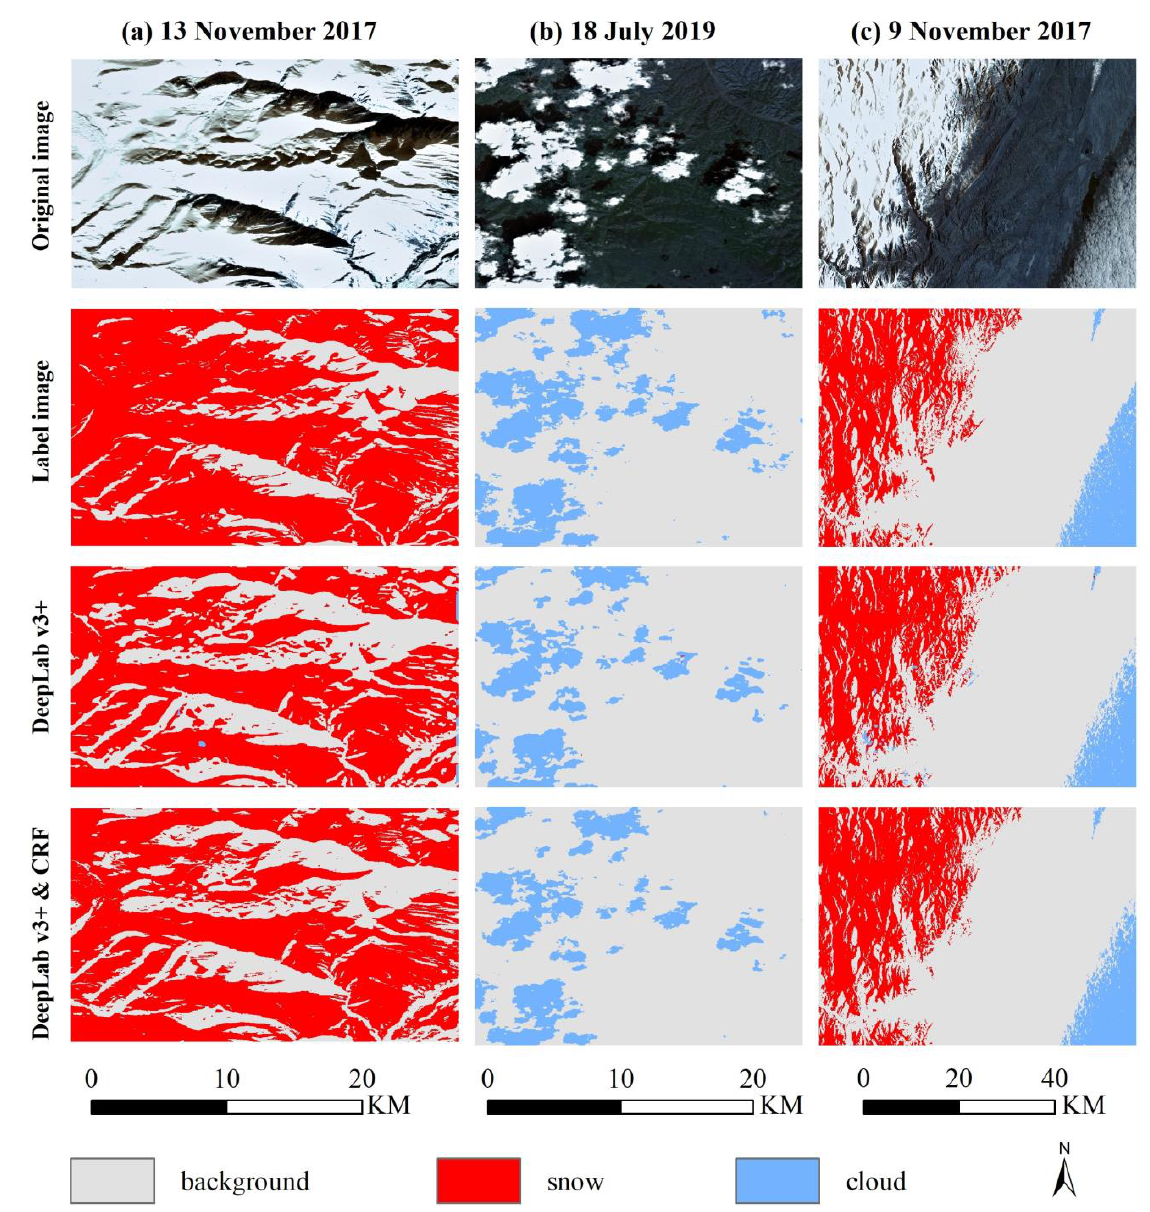
Figure 9. Comparison of cloud and snow identification between DeepLab v3+ and CRF post-processing. The three columns of subfigures ( a – c ) represent the original image, the label image, the DeepLab v3+ prediction map and the prediction map of DeepLab v3+ & CRF at three different dates,